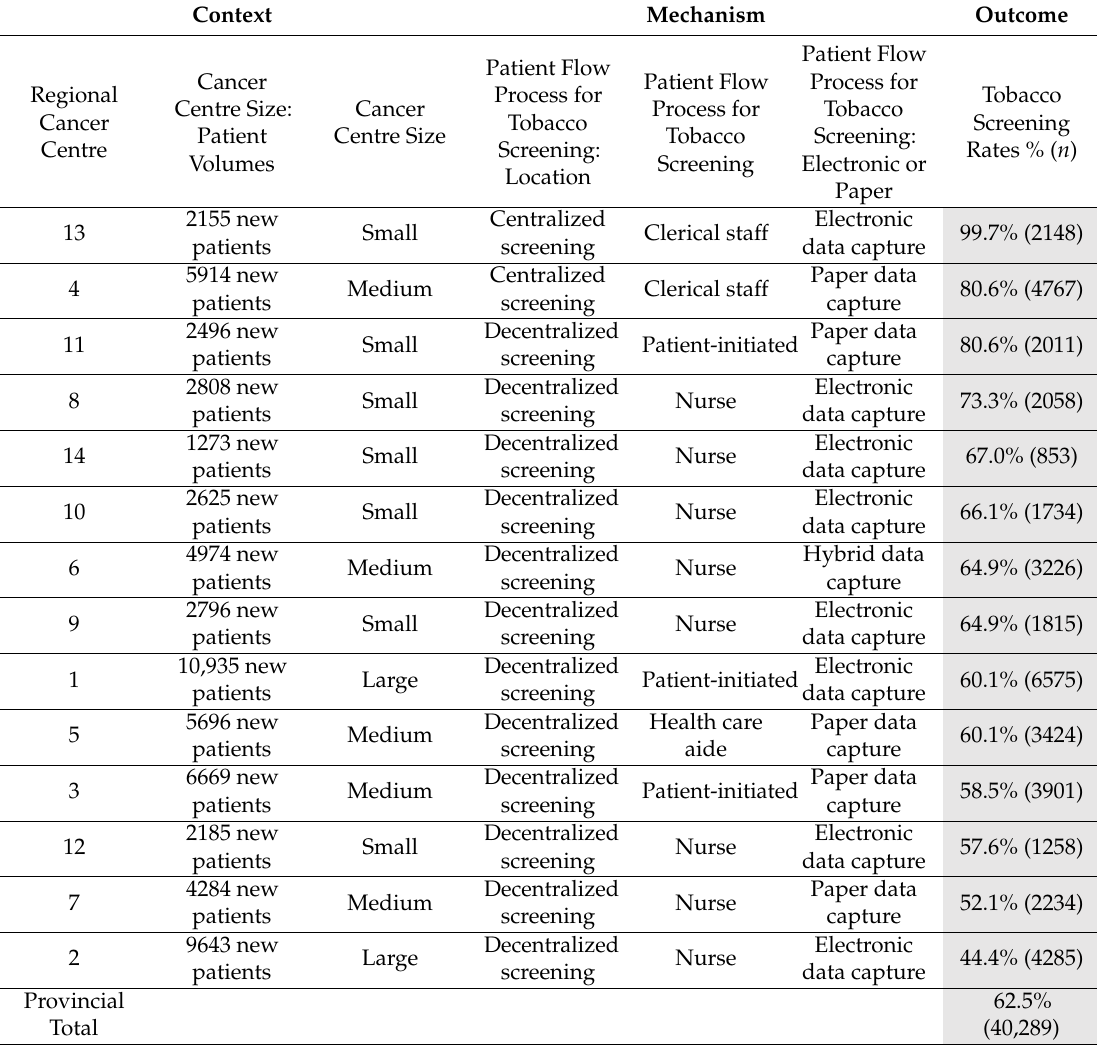
Table 2. Context and Mechanism variables that predict highest tobacco screening